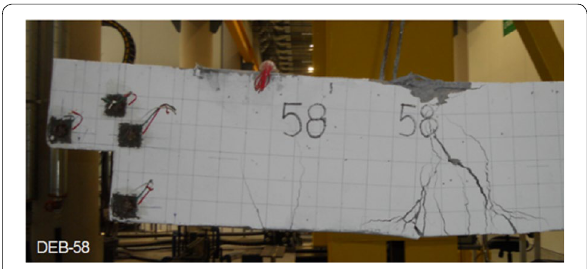
Fig. 20 The beams condition after testing (For